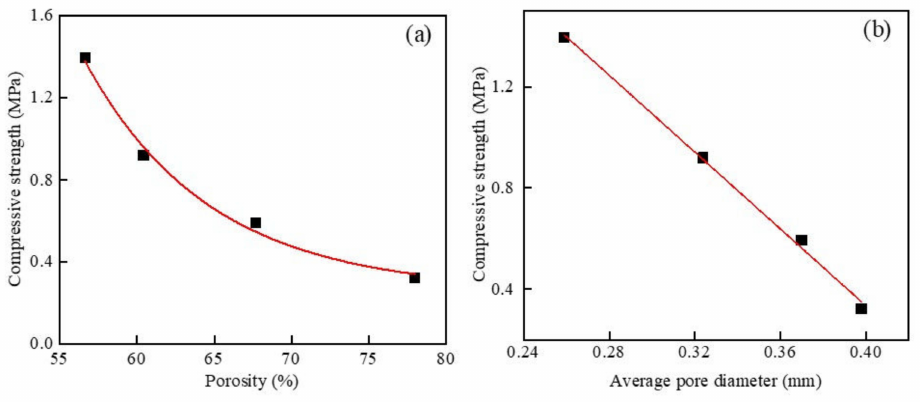
Figure 14. Compressive strength versus porosity ( a ) and average pore diameter of ( b ) the recycled foamed concrete containing MSWI powder with different